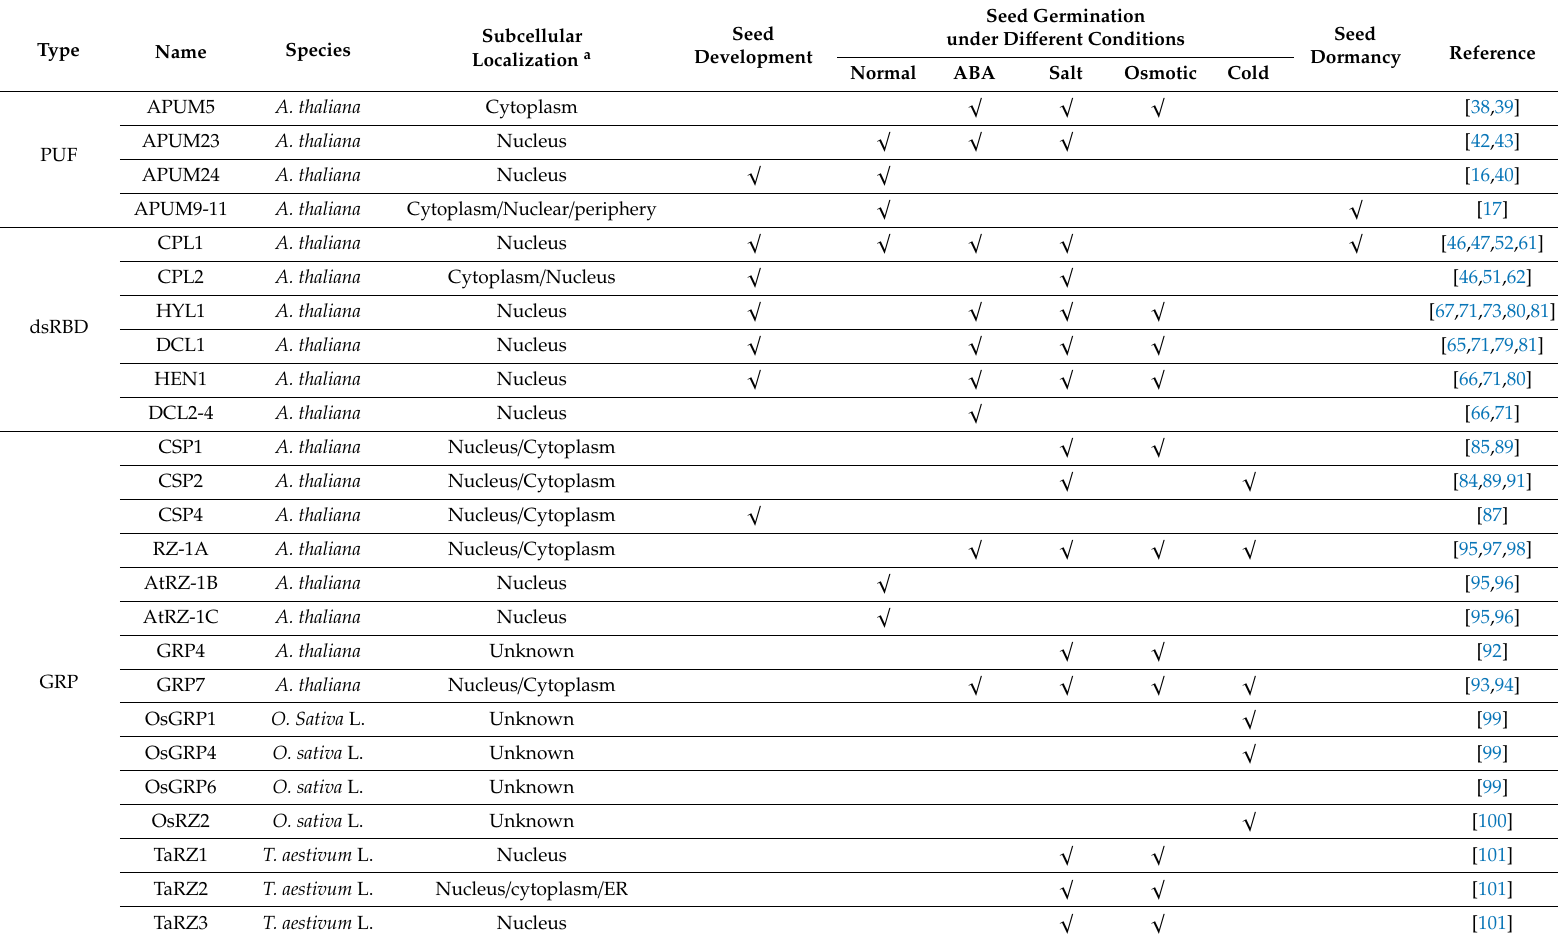
Table 1. List of plant known RBPs involved in seed development and